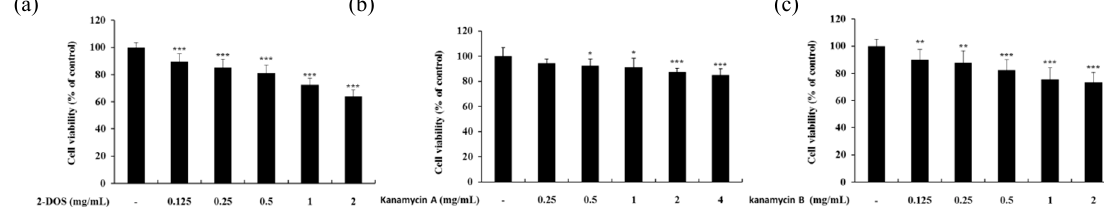
Figure 11. Cell viability of kanamycin A-( a ), kanamycin B-( b ), and 2-DOS-( c ) treated B16F10 melanoma cells. Cells were treated with various concentrations of these drugs for 72 h. Data are presented as mean ± standard deviation (SD) of at least four independent experiments ( n = 4). * indicates p < 0.05, ** p < 0.01, *** p < 0.001 vs. untreated cells.